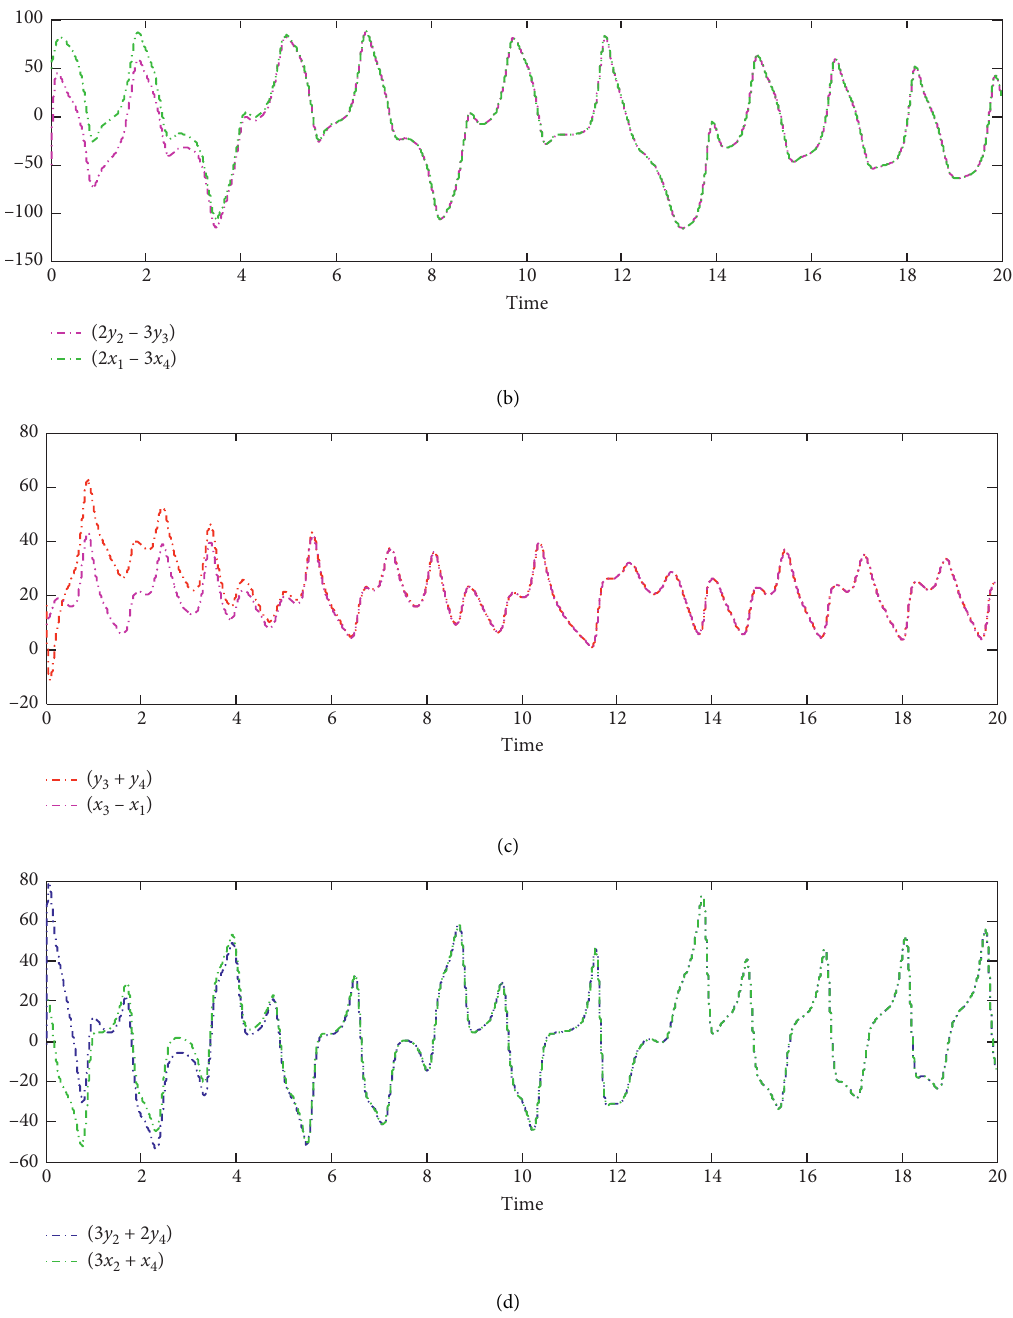
Figure 8: The Q-S synchronization of the response and drive